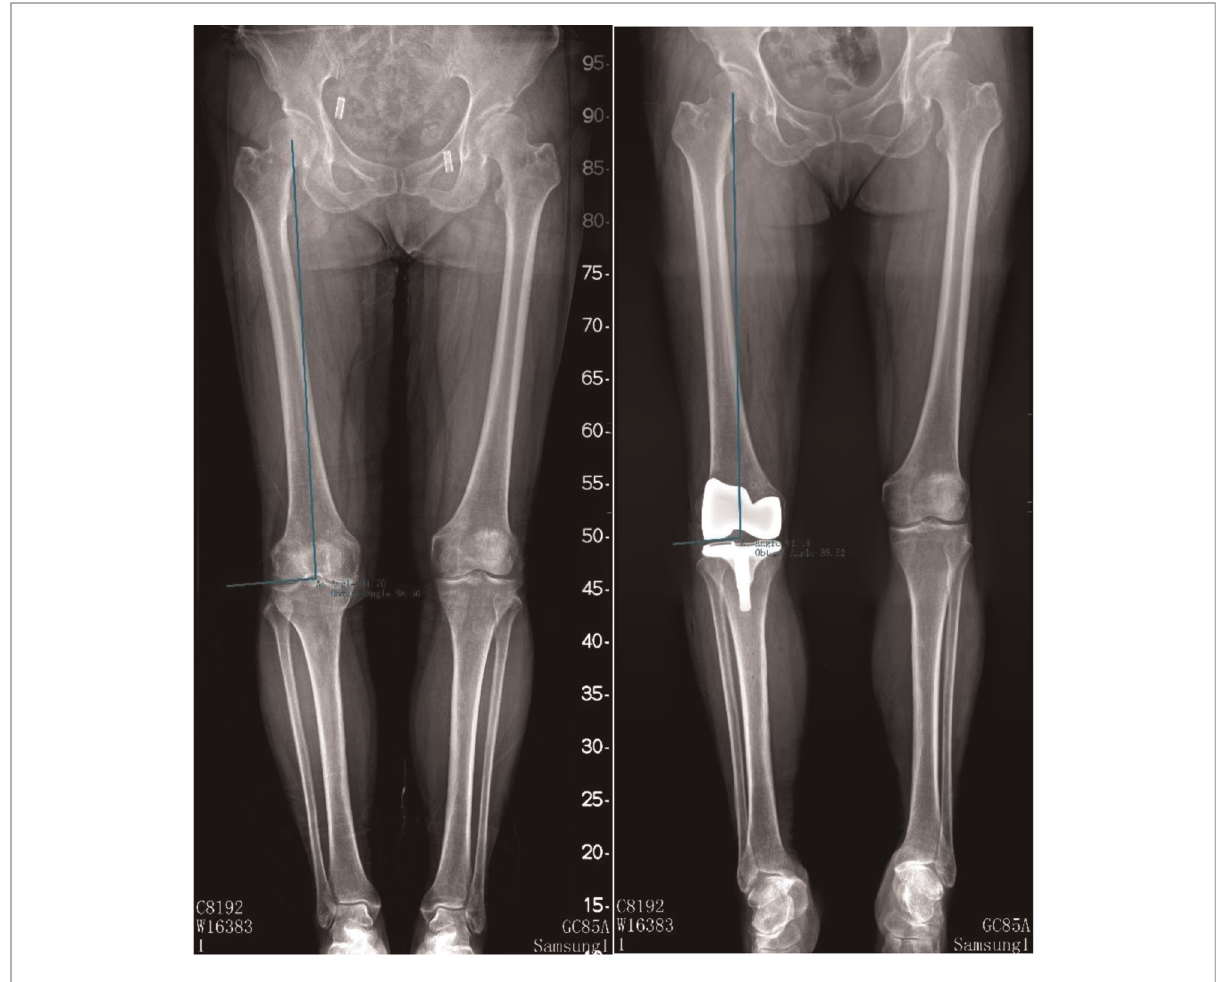
FIGURE 4 Pre-operation and post-operation LDFA measurement